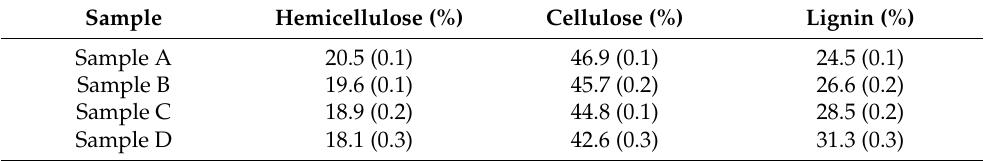
Table 1. The chemical compositions of the untreated and thermally modified bamboo